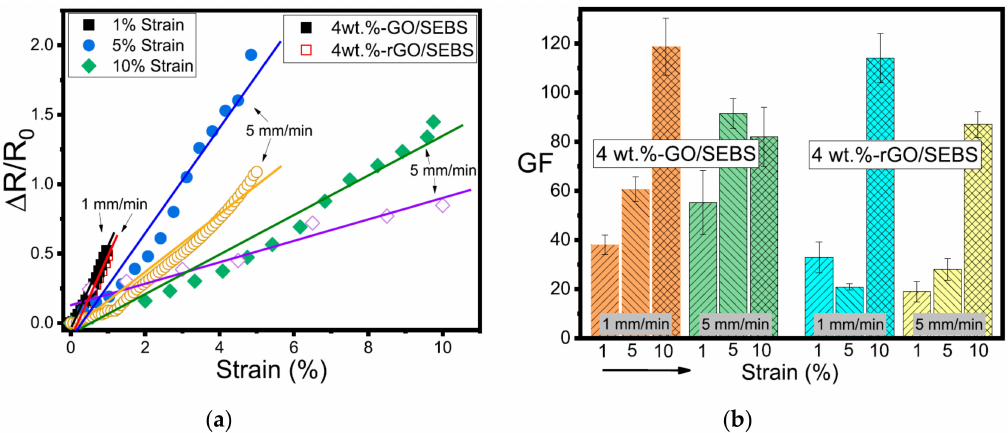
Figure 20. Electromechanical performances of GO / rGO SEBS polymer composites. ( a ) Relative electrical resistance change of the composites with strain; ( b ) GF of GO / SEBS and rGO / SEBS composites with 4 wt % filler content. Reproduced with permission from [89]. Copyright 2019, American Chemical